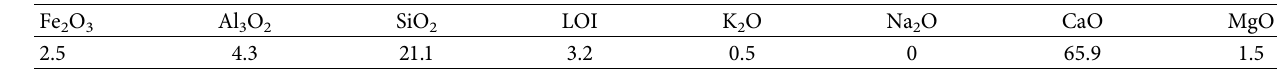
Table 2: Main chemical components of cement.